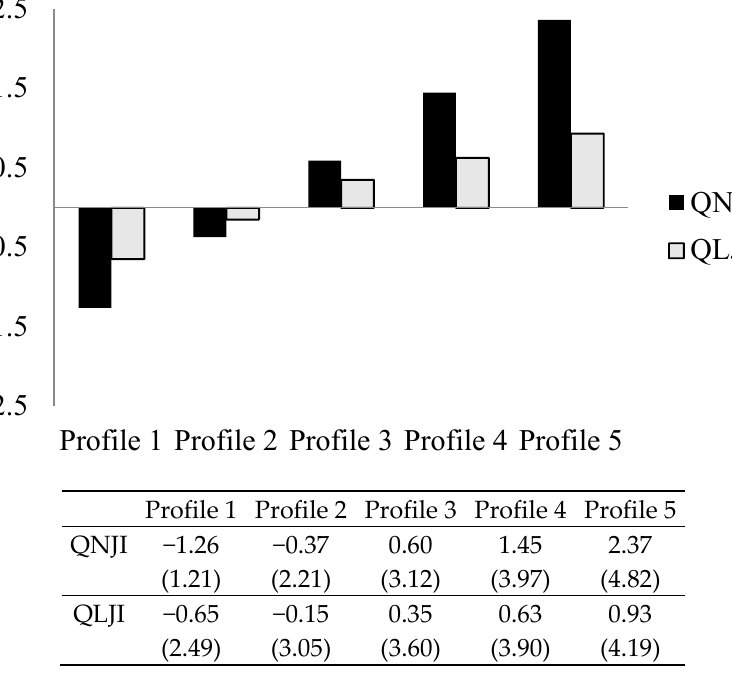
Figure 1. Graphical representation of the profiles of Sample 1. Scale scores between brackets. Q(N/L)JI = Felt Quantitative/Qualitative Job Insecurity.